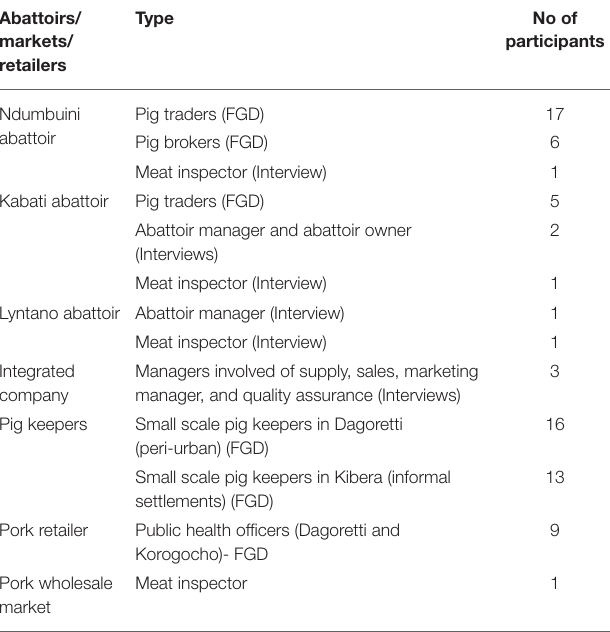
TABLE 1 | People interviewed for this